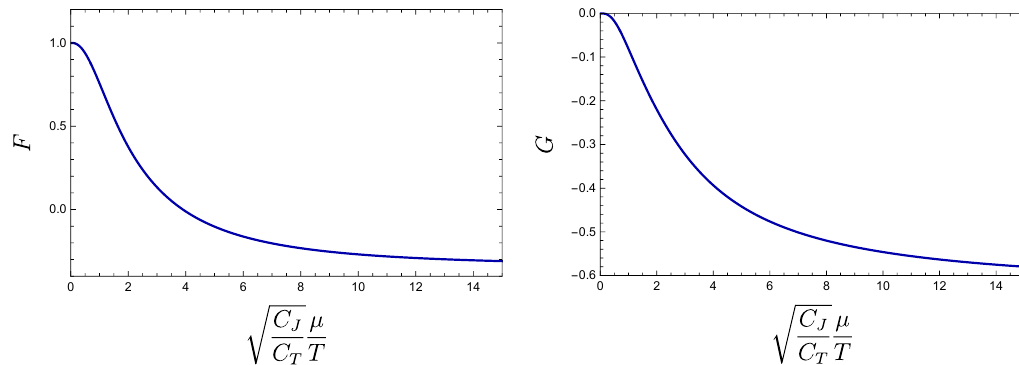
Figure 26 . The functions F ( (cid:23) ) and G ( (cid:23) ) de(cid:12)ned in eq. (D.16) which appear in the complexity of formation (D.15) for charged planar AdS 5 black holes as a function of (cid:23) (cid:17) In order to probe the limit of extremal black holes, i.e., T ! 0 with (cid:22) (cid:12)nite, we investigate expansion for x near m